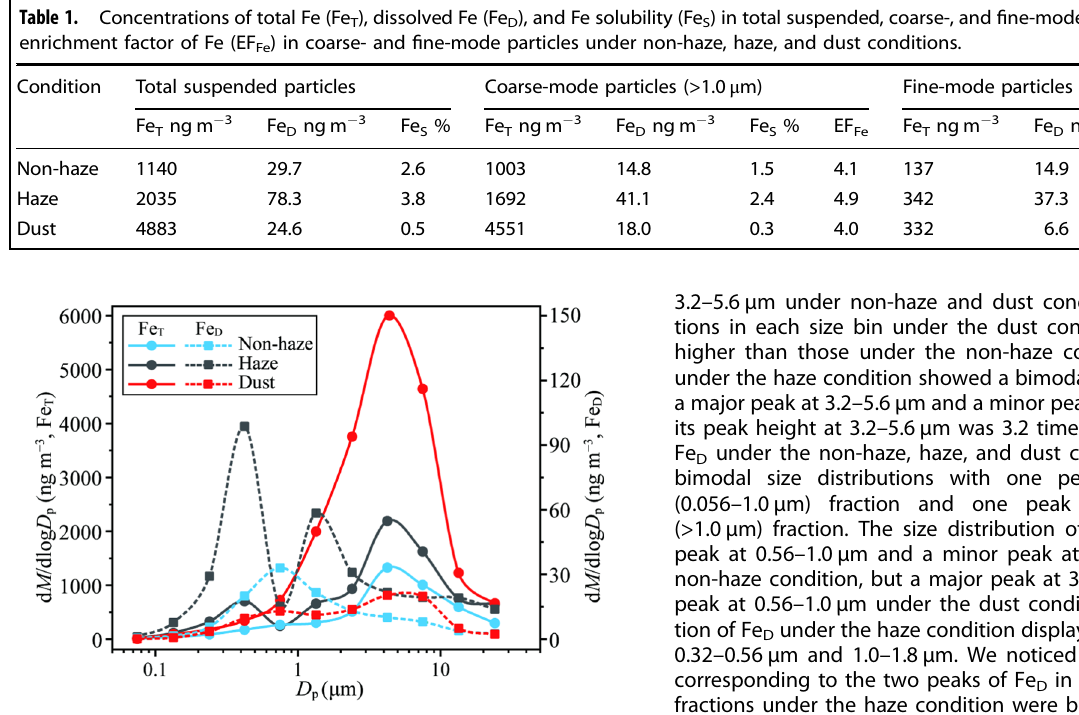
Fig. 1 Mass-size distributions of aerosol total Fe (Fe T , solid lines) and dissolved Fe (Fe D , dashed lines). The particle size refers to the aerodynamic diameter ( D p ). The distributions under non-haze, haze, and dust conditions are indicated by blue, black, and red lines,